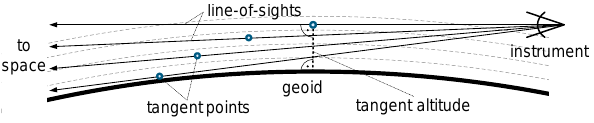
Figure 3. Limb-viewing geometry for a limb sounder. The instru- ment measures the radiance emitted by the atmosphere along the line of sight (LOS). The LOS altitude that is closest to the Earth surface is the tangent altitude; the corresponding point is the tan- gent point. The limb-viewing geometry yields relatively good verti- cal resolution as a result of the spherical geometry and the exponen- tial decrease of atmospheric density with altitude. GLORIA records radiance from all LOS